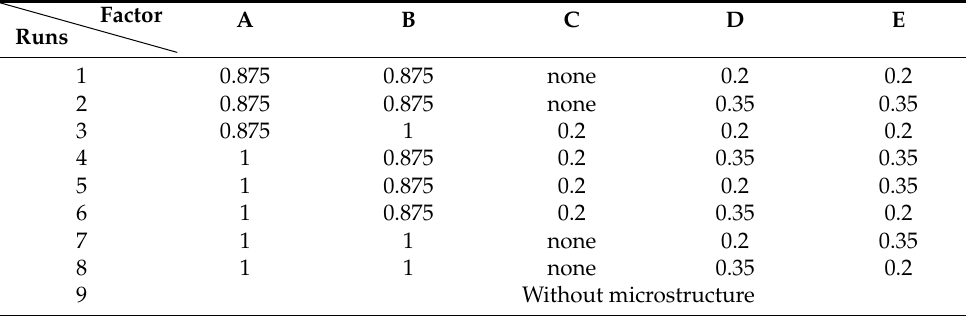
Table 2. Experiment for stagger and insertion type array.